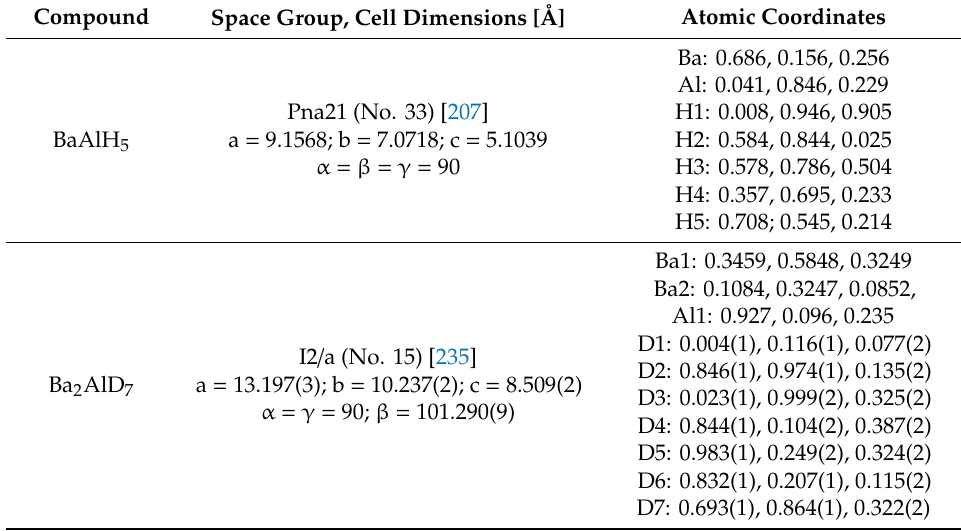
Table 11. Crystallographic data of barium-aluminum